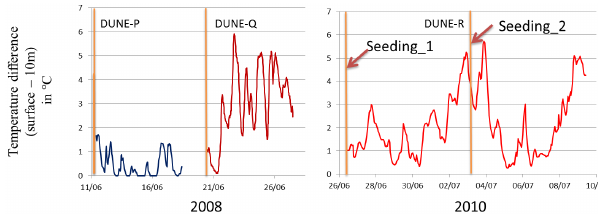
Fig. 9b. Evolution of the temperature difference between the surface and 10m illustrating both the diurnal variations and the evolution of the overall stratification.